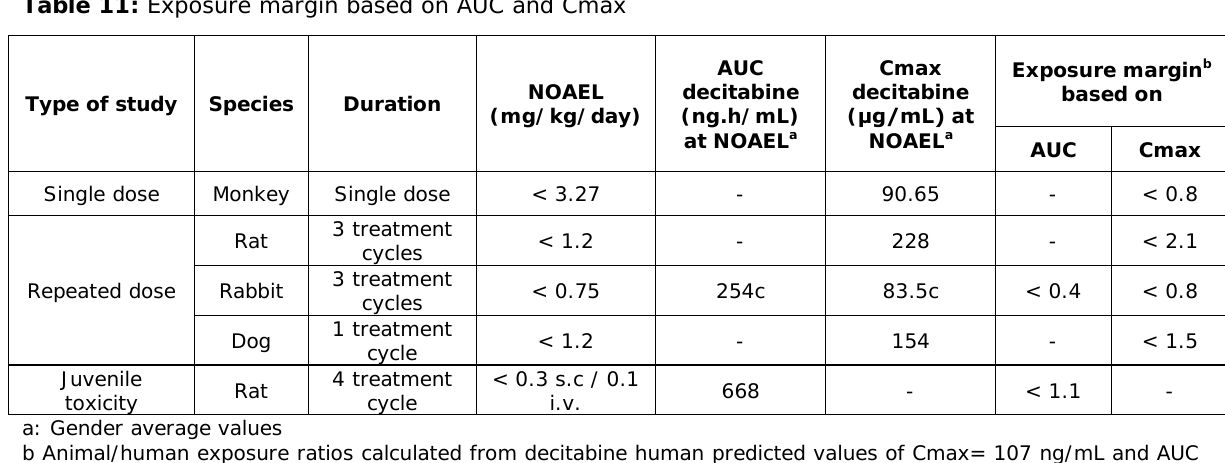
Table 11: Exposure margin based on AUC and Cmax